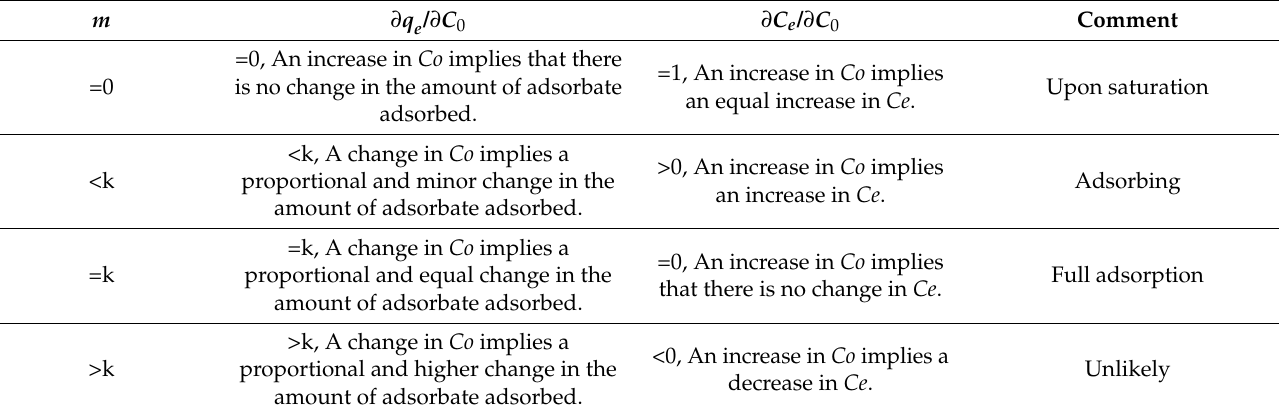
Table 4. Framework for the study of the dye concentration effect on the amount of adsorbate absorbed.